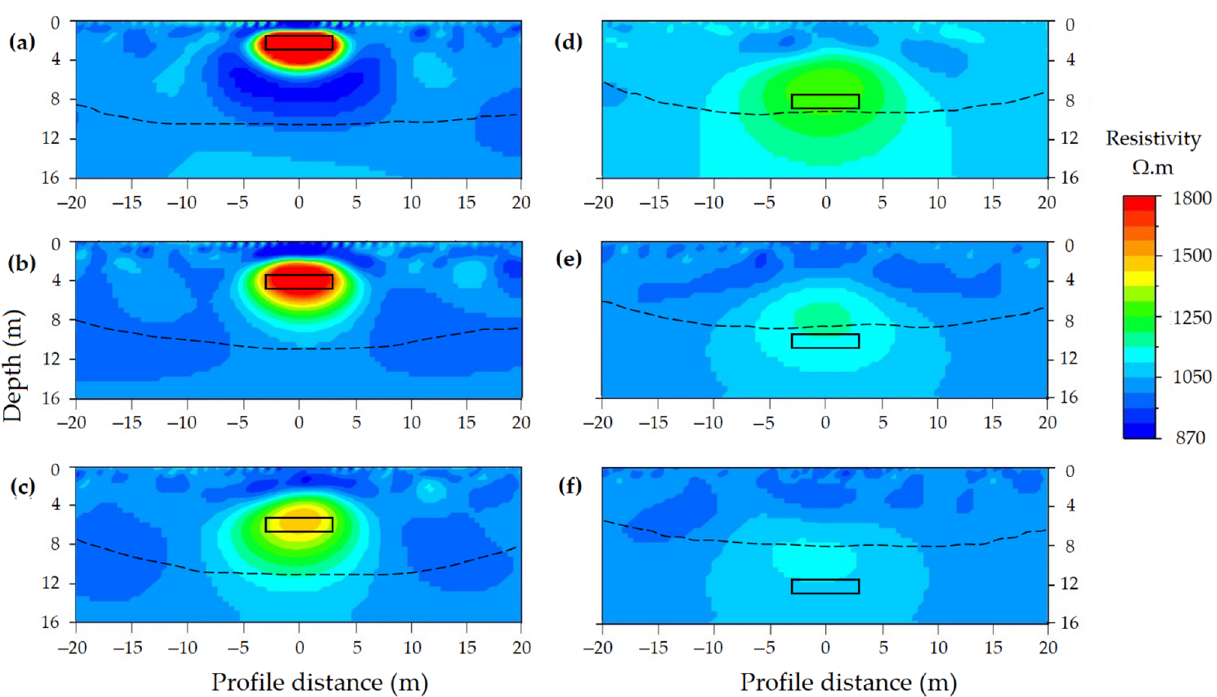
Figure 7. The inverted resistivity model using dipole-dipole (DD) array for the cavity targets: ( a ) T 1 , ( b ) T 2 , ( c ) T 3 , ( d ) T 4 , ( e ) T 5 , ( f ) T 6 . The rectangular boxes indicate the actual air-filled cavities. The broken lines represent the depth of investigation (DOI) threshold depths. For better anomaly illustration, we presented only a 40 m lateral model section.